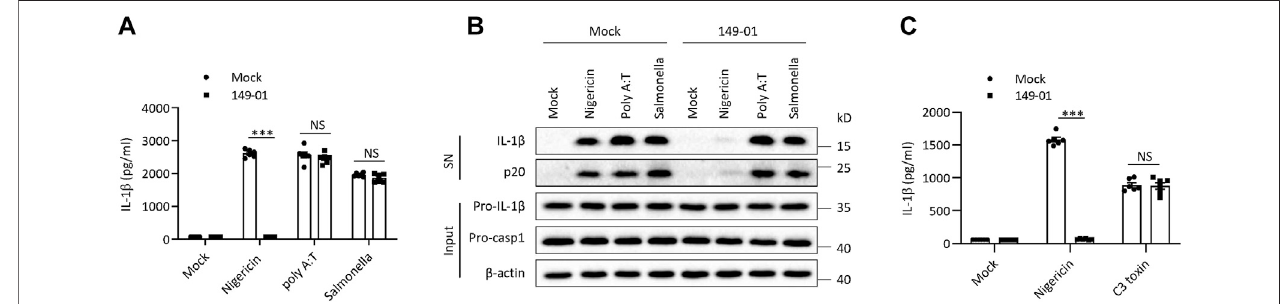
FIGURE2| 149-01doesnotaffecttheactivationofAIM2,NLRC4,orPyrinin fl ammasomes. (A – C) BMDMswere fi rstprimedwithLPS,thentreatedwithorwithout 149-01(600 nM)for30 min,lastlystimulatedwithnigericin,poly(A/T),SalmonellaorC3toxin. (A,C) IL-1 β releasesinsupernatantsweredetectedbyELISA. (B) ActiveIL- 1 β and p20 in supernatants and pro-IL-1 β , pro-caspase-1 and β -actin in cell lysates were measured by western blot. Data are obtained from three independent experiments,eachwithtwobiologicalreplicatesandareexpressedasmean±s.e.m( n =6) (A,C) ,orarerepresentativeofthreeindependentexperiments (B) .One- way ANOVA was applied to calculate statistical signi fi cance: *** p < .001, NS, not signi fi cant.